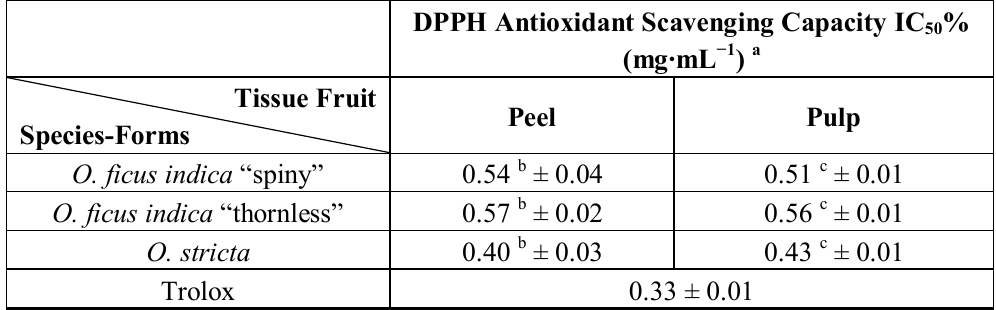
%) of two Tunisian O. ficus indica 50